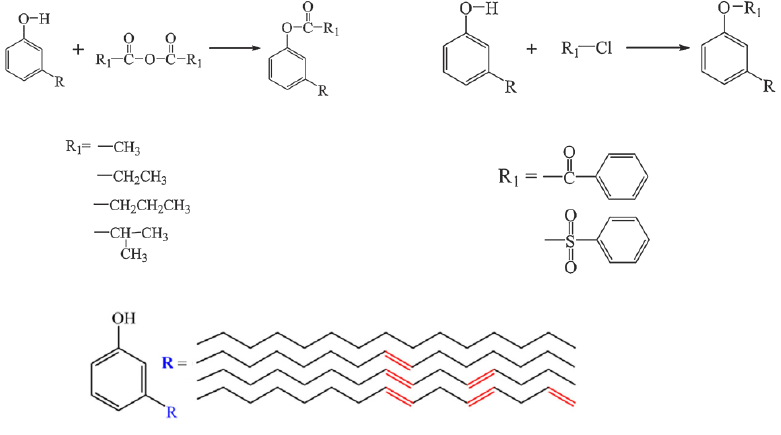
Figure 22. Synthesis of ester-amide of ricinoleic acid.